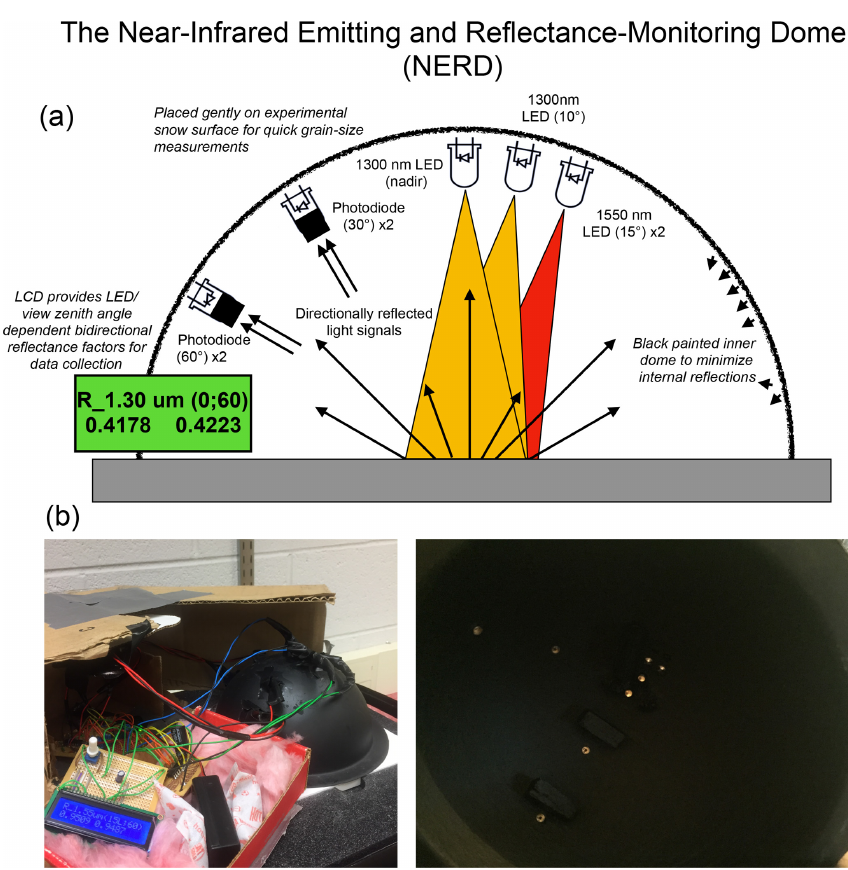
Figure 2. Near-Infrared Emitting and Reflectance-Monitoring Dome (NERD) schematic (a) and photographs (b) . The photograph on the bottom right shows the (radial) placement of photodiodes and LEDs (toward the center) within the dome.